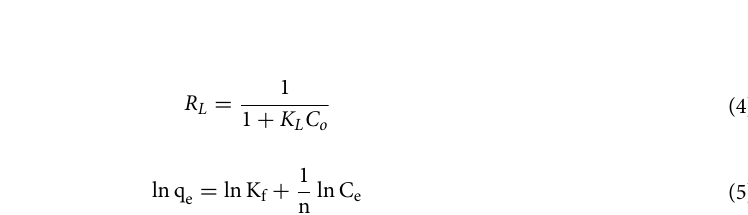
Table 2. Per correlation coefficients (R 2 ) in Fig. S2, the Langmuir isotherm model fitted perfectly with the inves- tigational data obtained (0.993 and 0.998), contrasted with the Freundlich isotherm model which displayed a small R 2 value. The theoretical maximum adsorption capacities Q o were 125 and 140.8 mg/g. The Q o values are near the experimental values of 118 and 137 mg/g of both MB and CV, respectively. Hence, our outcomes sug- gested that 1 g of used MMT-mAmCs adsorbent can adsorb around 0.125 and 0.141 g of MB and CV from the real wastewater. The obtained data indicated that the K L values are smaller than 1, indicating the reversibility of MB&CV adsorption. Values of 1/ n are additionally lower than 1, suggesting that the adsorption nature of MB and CV are chemisorption and favorable. The obtained value of R L between 0 and 1 indicates the favorability of the adsorption. In conclusion, the investigation confirmed that MB/CV dyes were adsorbed and formed a monolayer on the homogeneous MMT-mAmCs surface. The adsorbed MB&CV attached to the active sites of MMT-mAmCs through chemical bonds. The great sorption capacity of our MMT-mAmCs adsorbent qualifies it to be a suitable effective adsorbent to remove MB&CV from dyes-rich wastewater. Kinetic study of MB/CV‑removal.